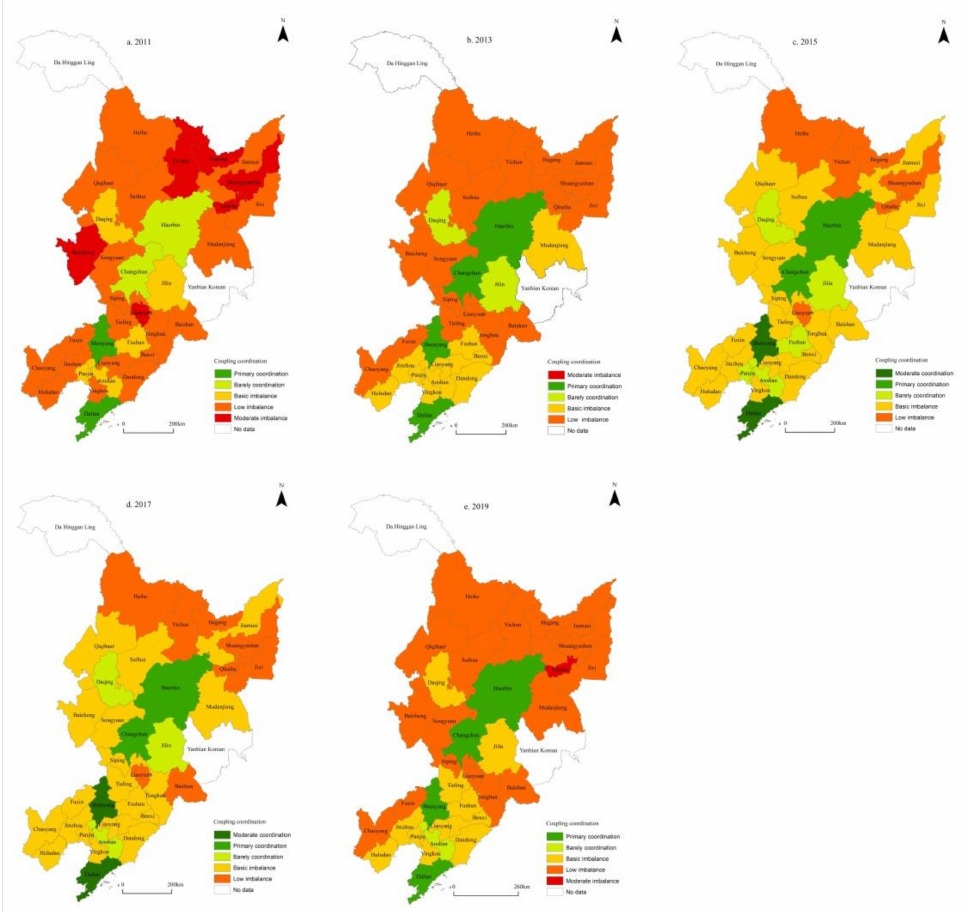
Figure 6. The spatial pattern of urban PHSs and RHSs coordination in northeast China in 2011–2019.